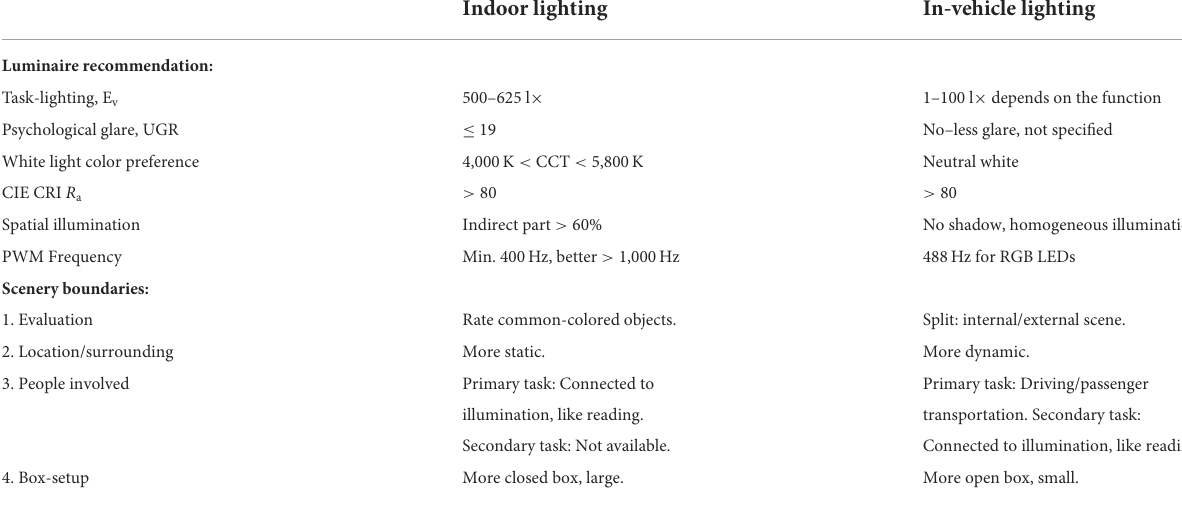
TABLE 1 Comparison of indoor lighting with in-vehicle lighting divided in luminaire recommendations and scene boundaries. Indoor